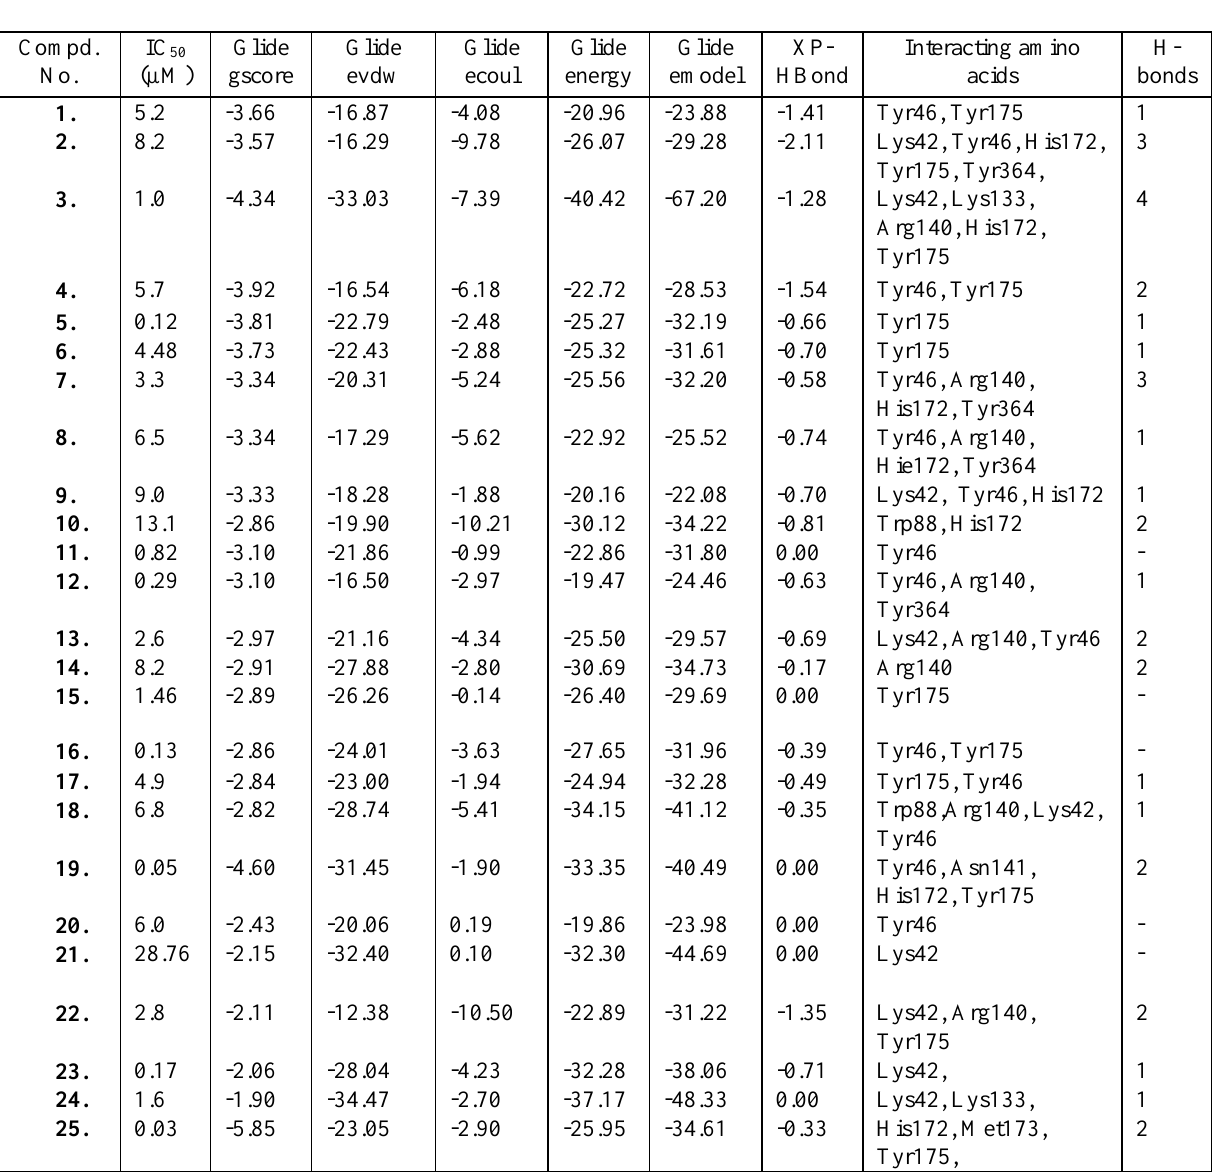
Table S2 . Extra precision docking results with interacting amino acids in the catalytic pocket of 1XFC (kcal/mol).